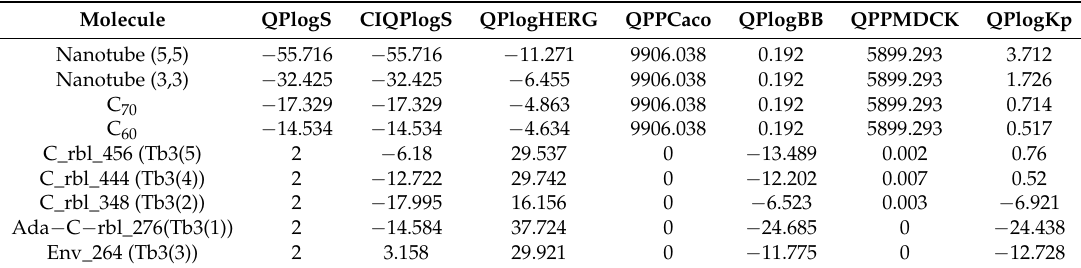
Table 5. Membrane related properties: QPlogS − predicted aqueous solubility n.v.( − )6.5 − 0.5;